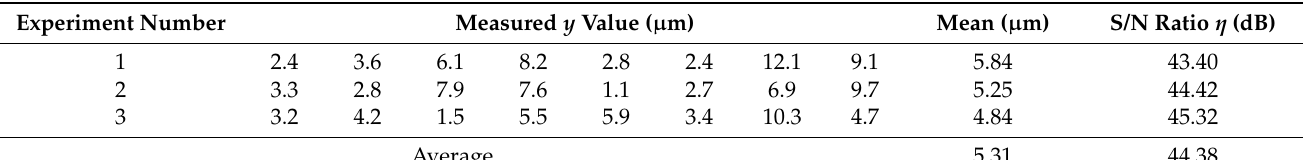
Table 13. Measured values, means, and S/N ratios of profile errors from verification experiments.